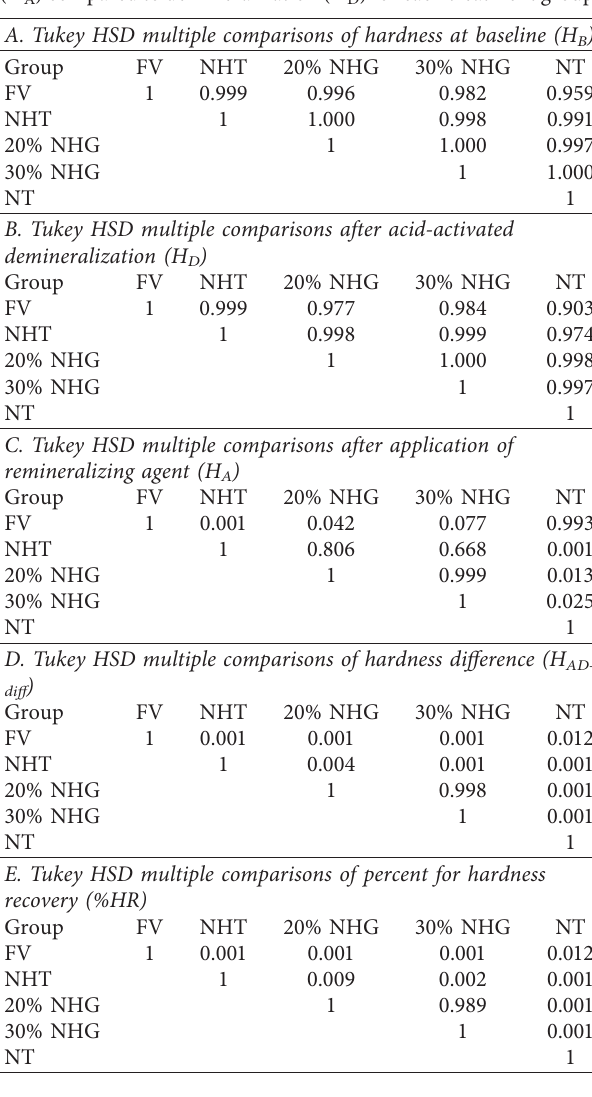
Table 4: Tukey’s post hoc multiple comparisons of hardness at baseline ( H B ), hardness upon demineralized process ( H D ), hard- ness upon an applied remineralizing agent ( H A ), hardness differ- ence determined between after demineralization and after remineralization ( H diff � H A − H D ), and percentage of surface microhardness recovery (%HR) after applied remineralizing agents ( H A ) compared to demineralization ( H D ) for each treatment